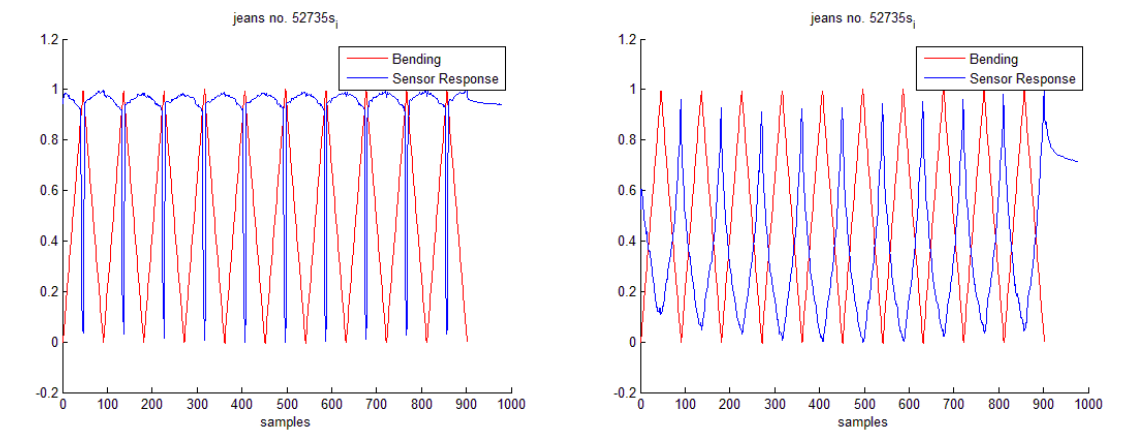
Figure 7. Normalized alignment, simple inner fold: ( left ) un-insulated case; ( right ) insulated